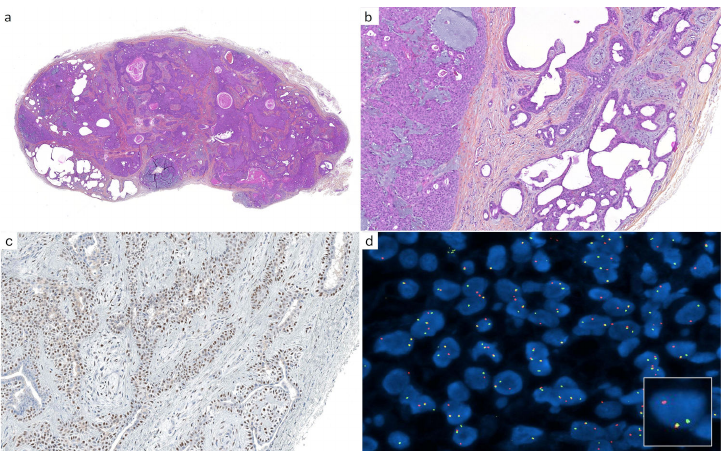
Figure 2. Cutaneous mixed tumor (chondroid syringoma): ( a ) cutaneous mixed tumor presenting as a circumscribed nodule, with cysts, ducts, nodules, and abundant stroma ( × 25); ( b ) higher magnification reveals different cell populations: myoepithelial aggregates (left), elaborated and cystic ductal structures (right), and mesenchymal cells associated with fibrous, fibromyxoid, and myxoid stroma ( × 100); ( c ) PLAG1 immunohistochemistry: diffuse nuclear staining is present, notably in the myoepithelial component ( × 200); ( d ) fluorescence in situ hybridization (FISH, break-apart probe) demonstrates a clonal PLAG1 gene rearrangement ( ×